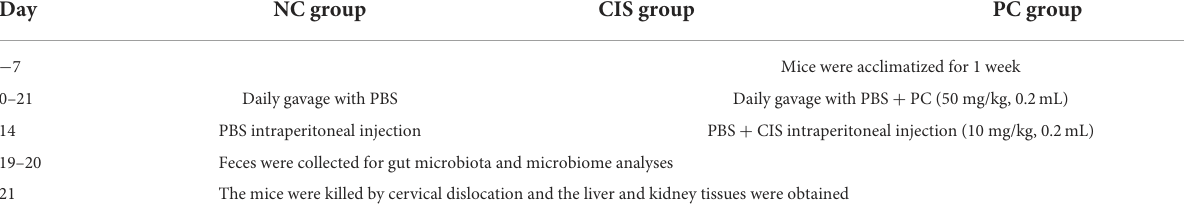
TABLE 1 The in vivo experimental design protocol.